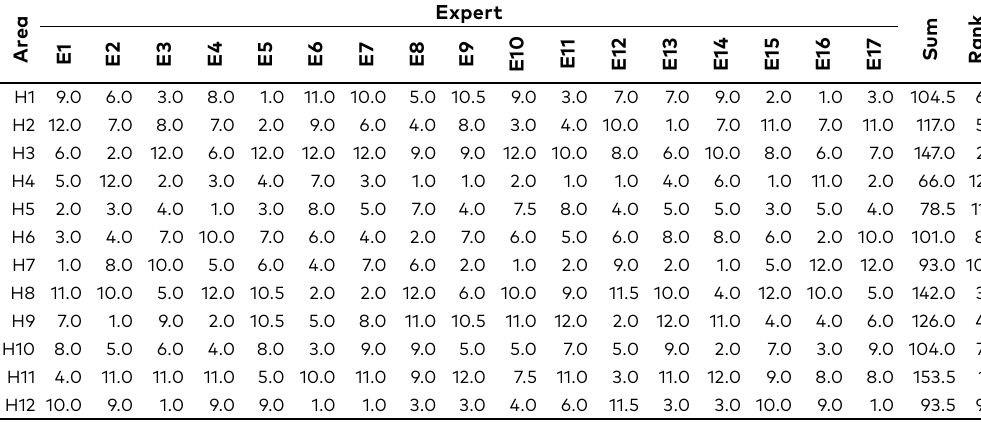
Table 5. The ranks of evaluating thematic areas in the big cities e A r